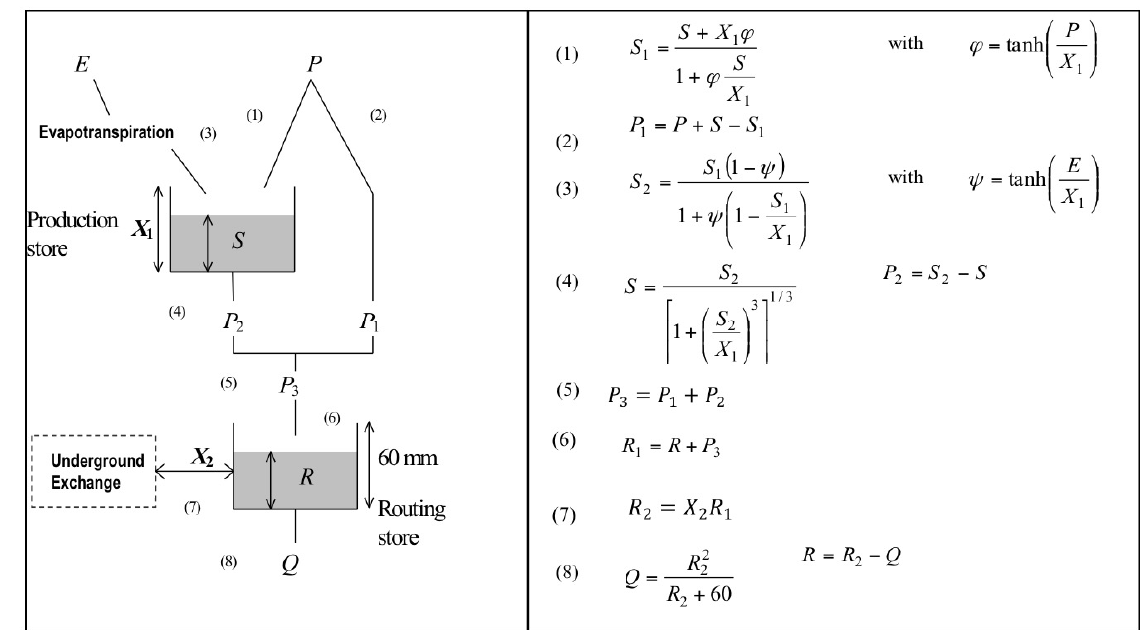
Figure 2. GR2M model scheme, describing precipitation (P), Evapotranspiration (E), water storage of the (S) reservoir, the precipitation that enters the soil (P 1 ), the amount of water that contributes (Table 2), the effective precipitation (P 3 ) and the gravitational water reservoir (R), the capacity of the reservoir-soil in mm (X 1 ), the coefficient of groundwater exchange (X 2 ), and runoff (Q) [62]. Source: CEMAGREF ( www.cenagref.fr ). Table 2. GR2M model performance (coefficient of determination R 2 and Nash-Sutcliffe